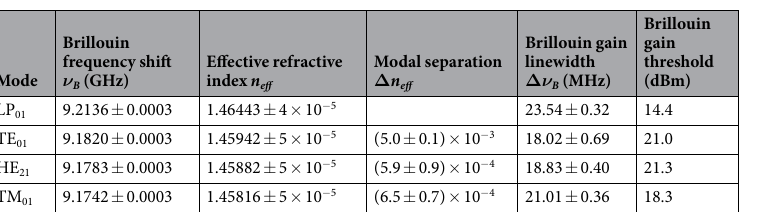
Table 1. Characteristics of the Brillouin gain spectra of vector modes.